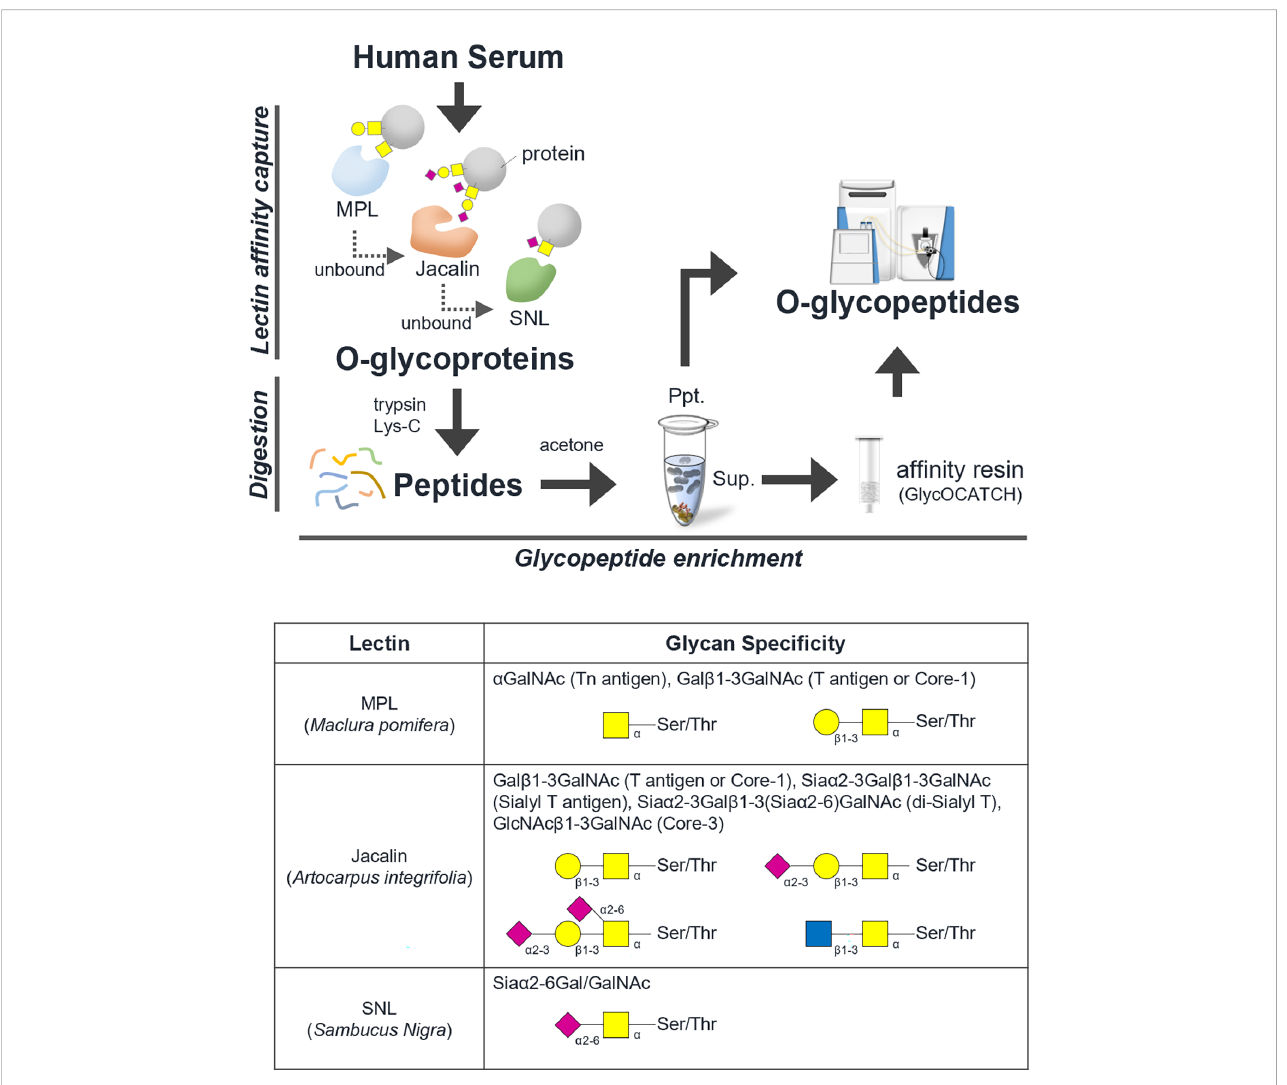
FIGURE 1 Schematic work fl ow of O-glycoproteomics. The comprehensive analysis of intact O-type glycopeptides was broadly divided into three stages. Step 1: Concentration of O-glycoprotein by lectin af fi nity, Step 2: trypsin/lysyl endopeptidase digestion, Step 3: concentration of O-glycopeptide using acetone and GlycOCATCH af fi nity resin. A list of glycan speci fi cities of lectins used in this study is